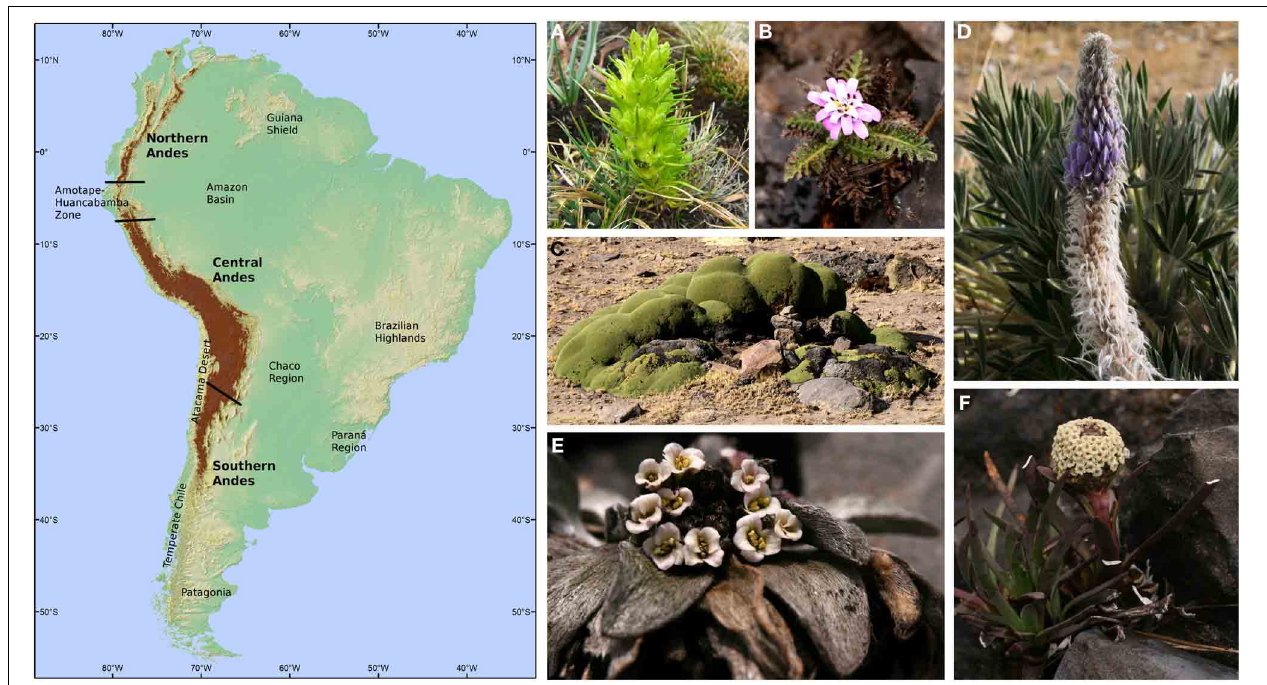
FIGURE 1 | Left panel: South American map showing the major geographical Andean units discussed in the text and approximate location of the most commonly used geographical areas. Brown area are elevations above 3000m. Right panel: Selected high Andean plants. (A) Gentianella